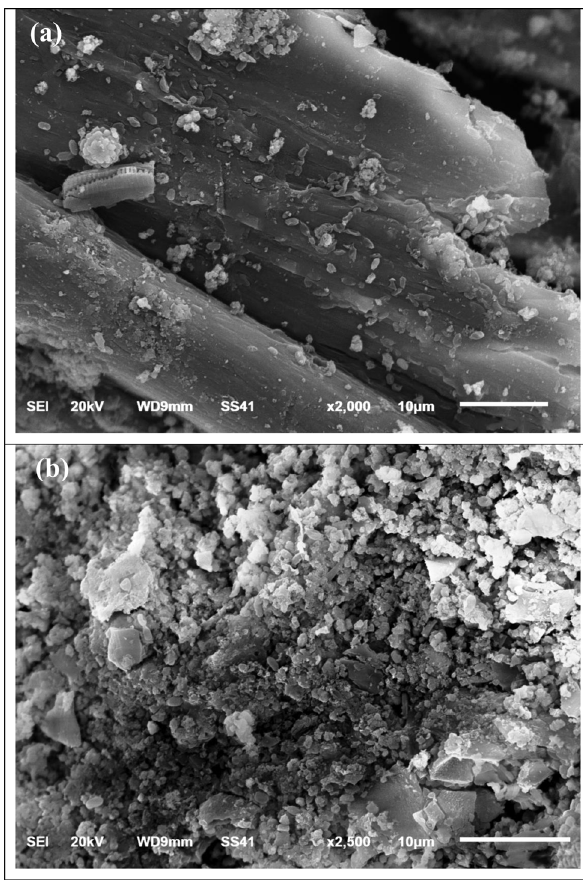
Figure 6: SEM micrograph of G. amansii biomass: ( a ) before and ( b ) after adsorption of Ni 2 + ions from aqueous solution.